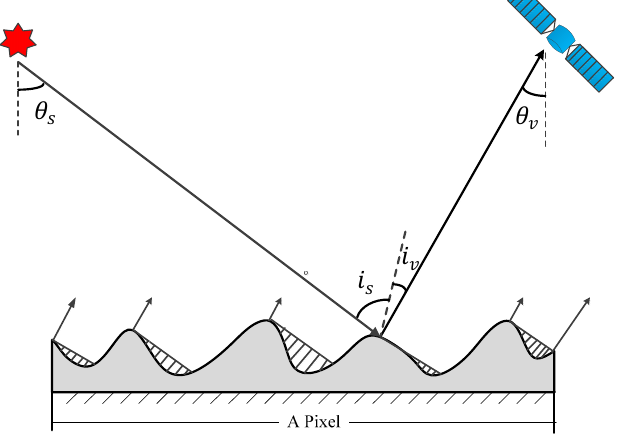
Figure 11. Radiative transfer process over the composite slope terrain.